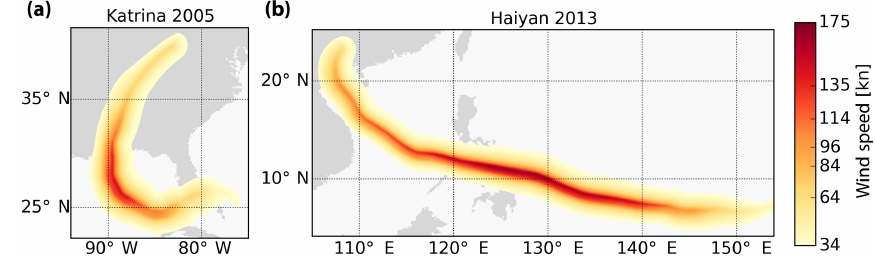
Figure 1. Example wind fields for Hurricane Katrina affecting the United States in 2005 (a) and Typhoon Haiyan affecting the Philippines in 2013 (b) as generated using the Holland08 wind field model. The color bar ticks highlight the relevant wind speed thresholds from the Saffir–Simpson scale in knots.